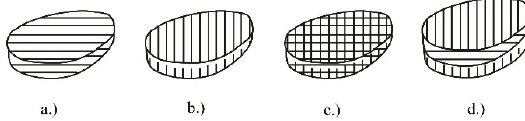
Figure 5. Scanning direction: ( a ) x axis, ( b ) y axis, ( c ) xy combination, ( d ) alternating [27].